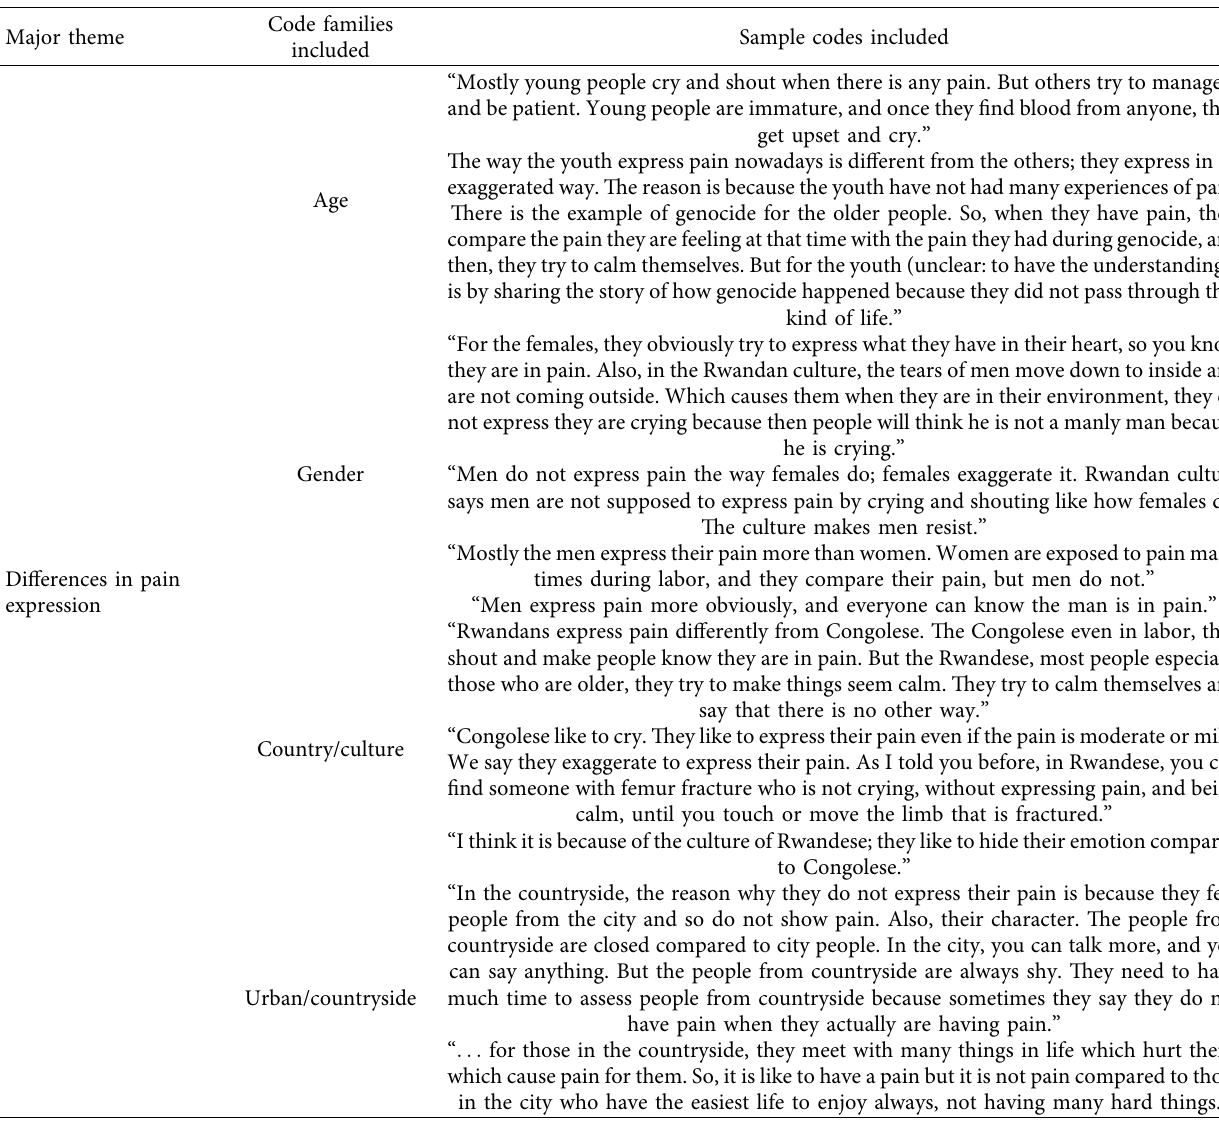
Table 2: Qualitative themes,